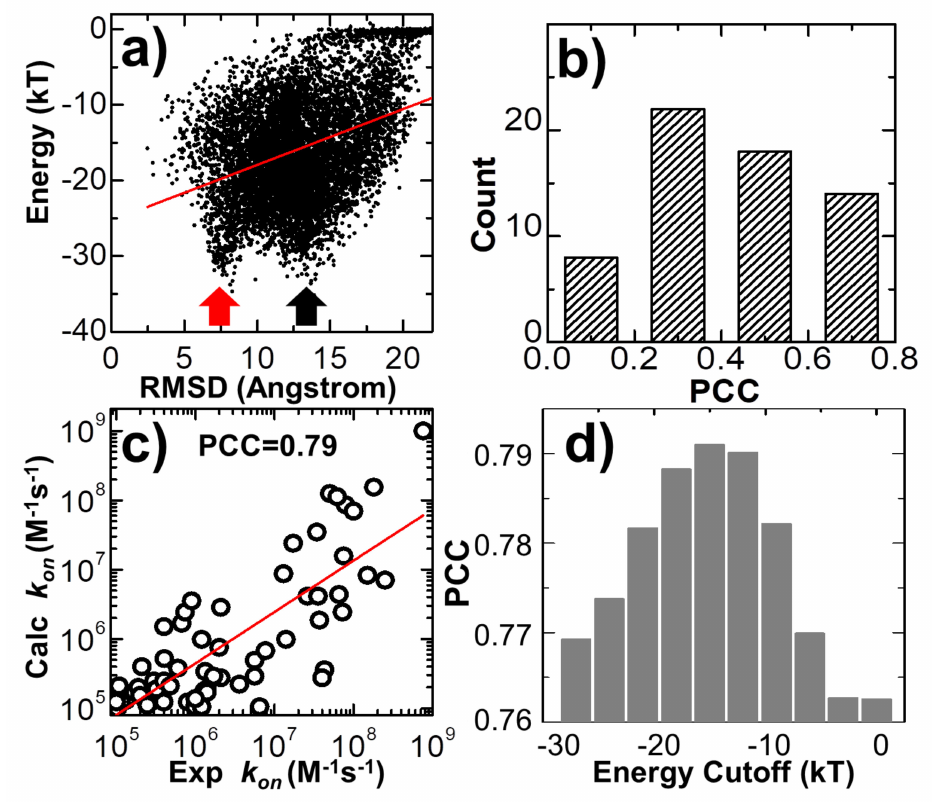
Figure6. WecomparedthevaluesofRMSDwithintermolecularenergyforallthe10 4 finalconfigurations taken from the simulations of protein complex 2VLN in ( a ). We also calculated the correlation between RMSD and intermolecular energy for all 62 protein complexes in the benchmark. The distribution of these calculated Pearson correlation coe ffi cients is plotted in ( b ). We further enumerated the combination of di ff erent binding criteria for encounter complex formation. The log 10 base plot in ( c ) shows that by optimizing the combinations and values of di ff erent binding criteria, we were able to achieve a high correlation between experimental and simulated association rates for all protein complexes in the benchmark. Finally, using energy cuto ff as an example, we found that the high correlation between simulation results and experimental data could only be achieved when the values of the binding criteria were adopted within a small range ( d